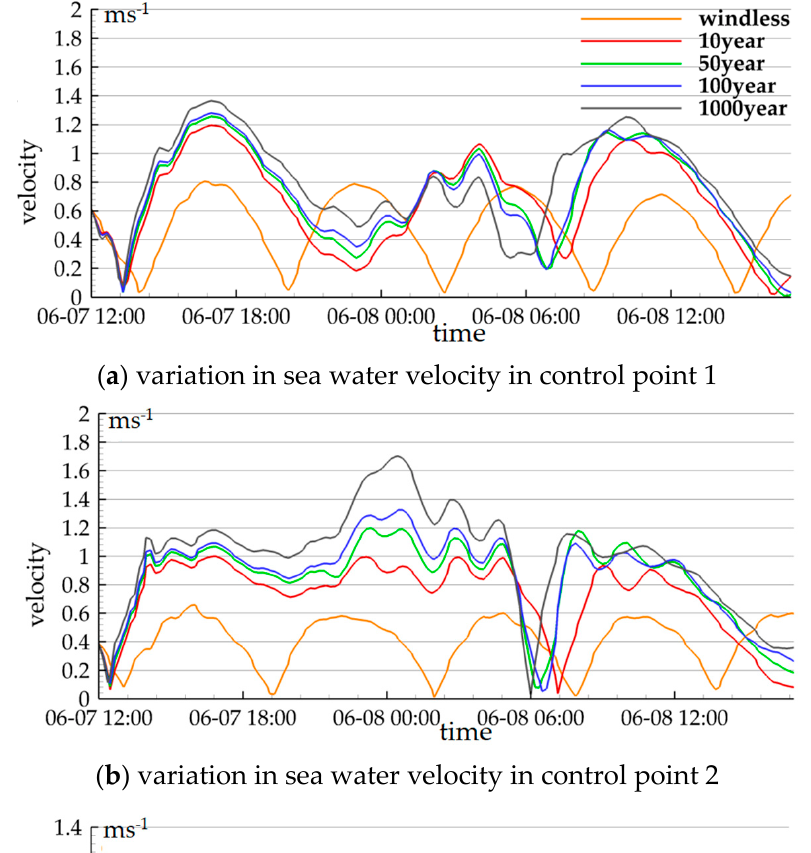
Figure 16. The increment in water level of typhoon in different recurrence periods.